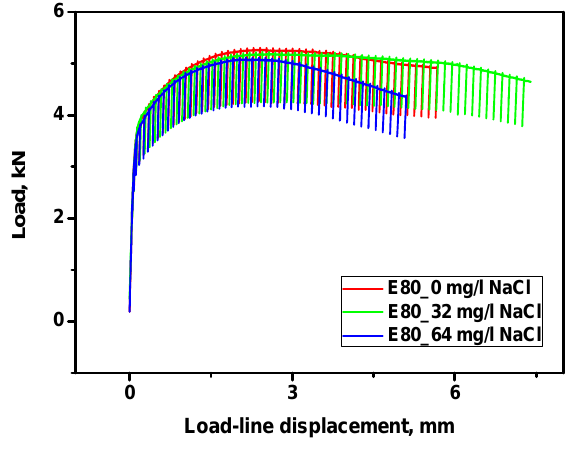
Figure 9. Typical Load-Displacement plots of MAS in E80 with 0, 32, and 64 mg/L NaCl.